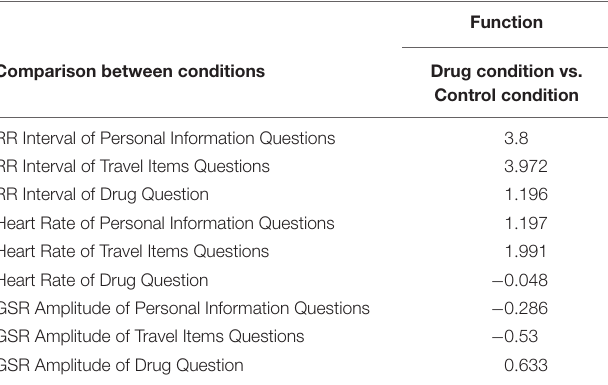
TABLE 2 | Standardized canonical discriminant function coefficients in Experiment 1.